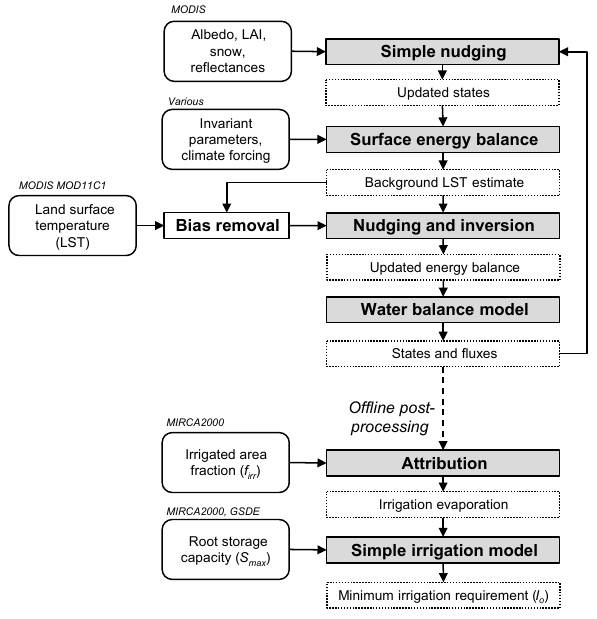
Figure 1. Illustration showing the processing steps and data used in each step. Acronyms relate to the input data that are described in the